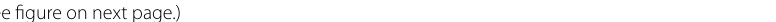
EV2007(See figure on next Fig. 3 a Observed and synthetic waveforms for EV2003. The top trace in each pair, denoted DATA, is the observed ground velocity waveform; the bottom trace, denoted as SYN, is the corresponding synthetic computed for the FAMT parameters. The horizontal components with respect to the FDM grid are used in the FAMT analysis so that the last characters X and Y in the component name denote the directions of the horizontal ground motions (Fig. 1a). The character U denotes upward ground motion. The first two columns from TYS-X to HRO-U display the short-period waveforms with a passband of 4–40 s; the remaining columns display the long-period waveforms with a passband of 10–40 s. The numbers next to each pair denote the maximum amplitude ( 10 − 3 cm/s) of the observed waveform. The estimated moment magnitude and the normalized residual ( F in Eq. 1) are shown at the top. The obtained source time function (STF) and the moment tensor are also plotted in the bottom-right corner. b Same as a but for EV2007. c Detailed comparisons of the observed velocity waveforms (DATA: red) and the synthetic waveforms computed using 3D (blue) and a flat-layered structure model (1D: gray) at station TYS and HRO. d Same as c but for